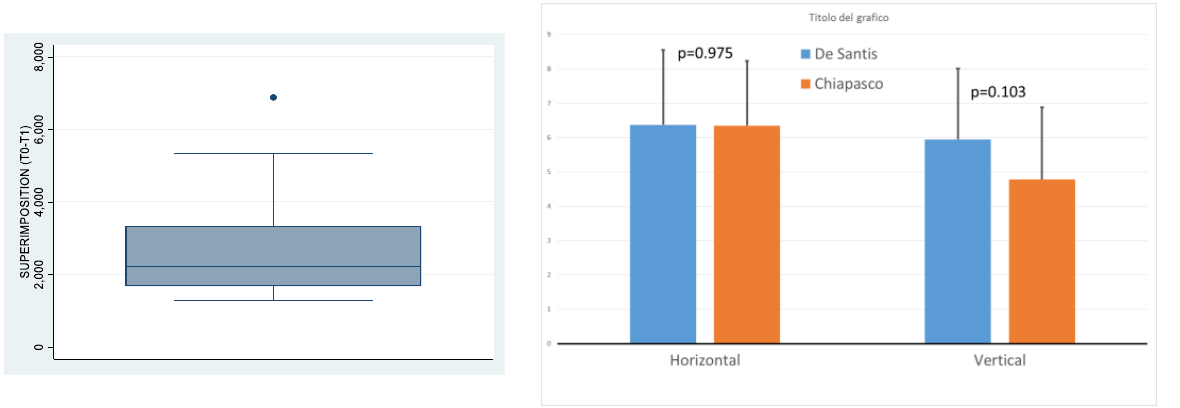
Figure 8. Maximum and vertical gains, obtained in the present series, are compared with historical data, and the significance of differences was evaluated by the t -test for unpaired data, after verifying the homoscedasticity and normality assumptions.